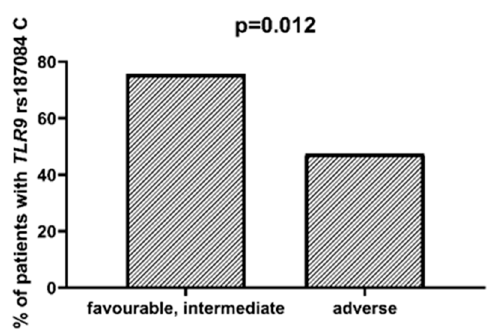
Figure 1. Association between TLR9 rs187084 C and risk according to ELN.